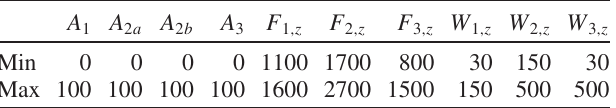
TABLE II. The range of priors of the model parameters used in the calculation of the posterior distributions on λ z . Additional prior constraints defined by A 1 ;z > A 3 ;z , A 2 a > A 2 b , and s z < W = 5 are also 2 ;z